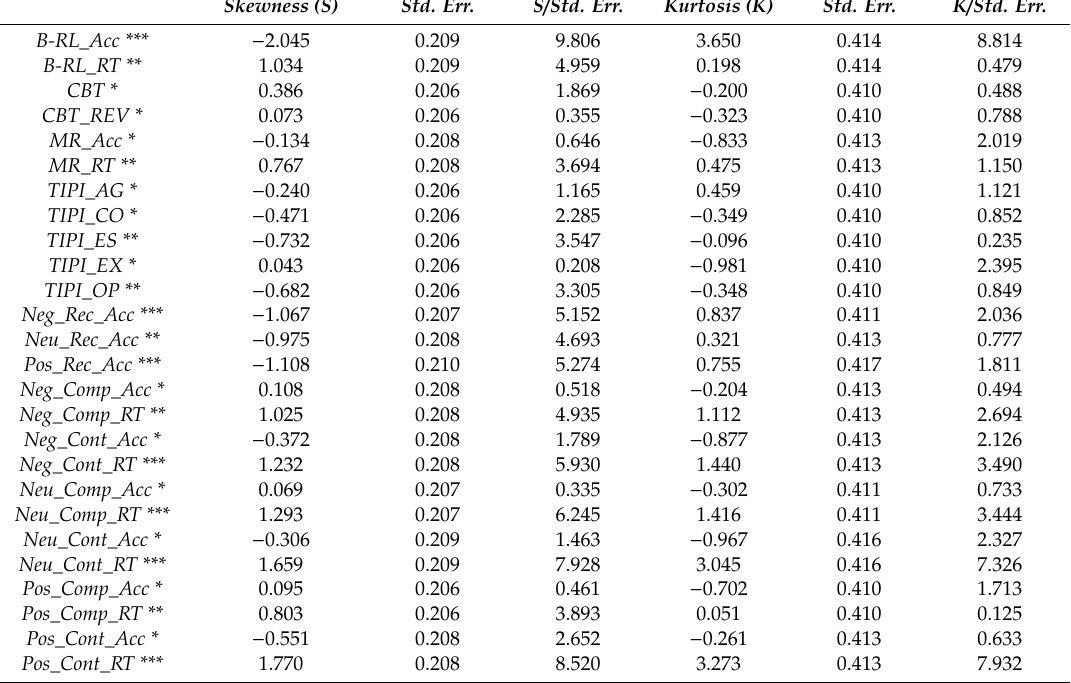
Table A2. The table reports the skewness and kurtosis values for all the variables of the study. A z -test was applied for normality test using the skewness and kurtosis values. The z -score was obtained by dividing the skew values and kurtosis by their standard errors (see third and sixth columns). In line with West et al.’s suggestions (1996), all the absolute z -scores over 3.29, which corresponds with an alpha level of 0.05, would suggest a non-normal distribution. Therefore, we indicated with one asterisk (*) all variables whose distribution did not substantially di ff er from normality, with (**) all distributions that slightly di ff ered from normality, with (***) all distributions with severe departure from normality. Abbreviations: Acc = accuracy; RT = response time; B-RL = Bergen right / left test; CBT = Corsi block test; REV = reversed; TIPI = Ten item personality inventory; AG = agreeableness; CO = conscientiousness; ES = emotional stability; EX = extraversion; OP = openness; Neg = negative; Neu = neutral; Pos = positive; Cont = route continuation task; Comp = distances comparison task. Skewness (S) Std. Err. S / Std. Err. Std.